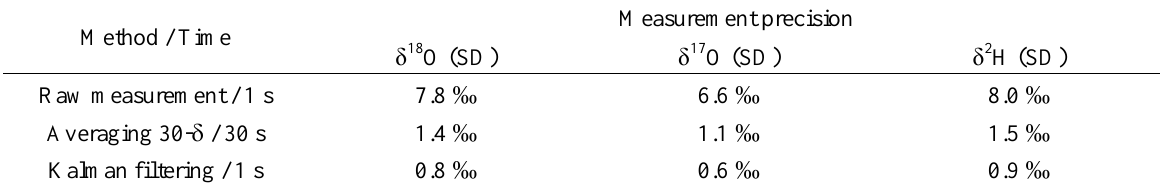
Table 3. Measurement precision comparison: Raw measured  -value from the average of 10 laser scans in 1 s, data from conventional averaging of 30 measured  -values within the optimal average time (30 s) determined by an Allan variance analysis, and 1 s Kalman filtering data with q =